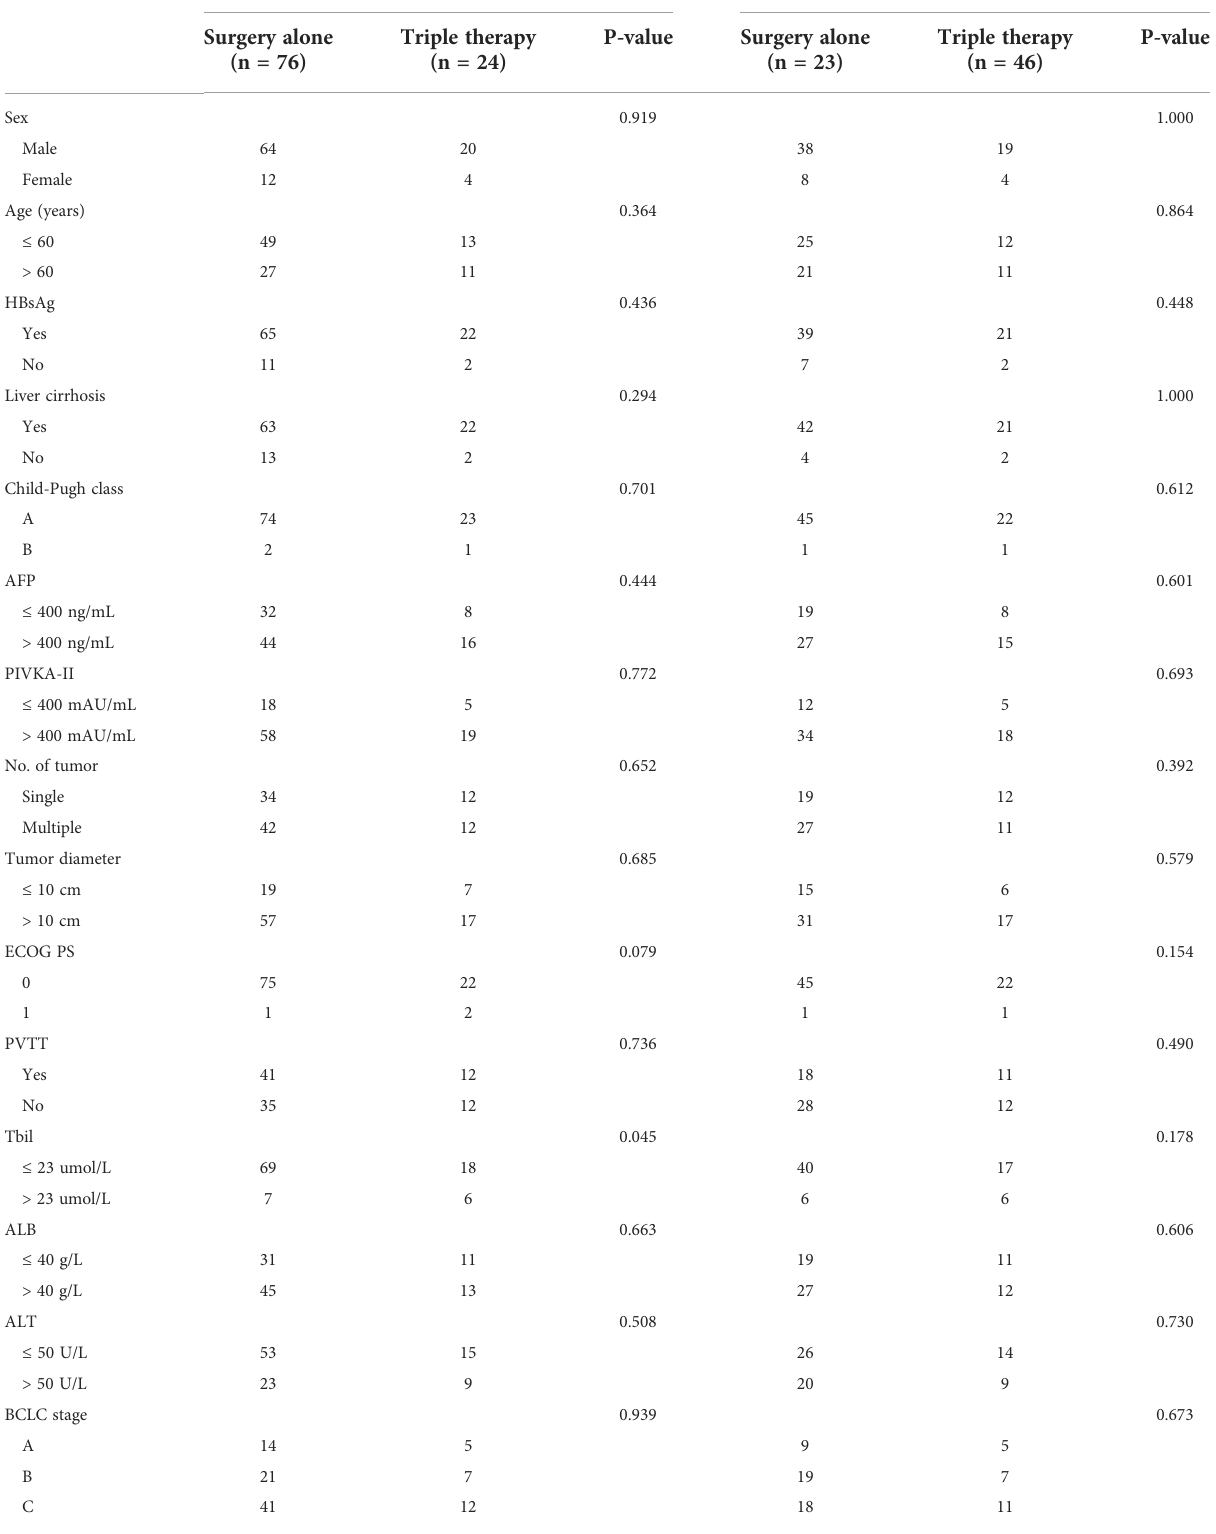
TABLE 1 Preoperative patient demographics and tumor